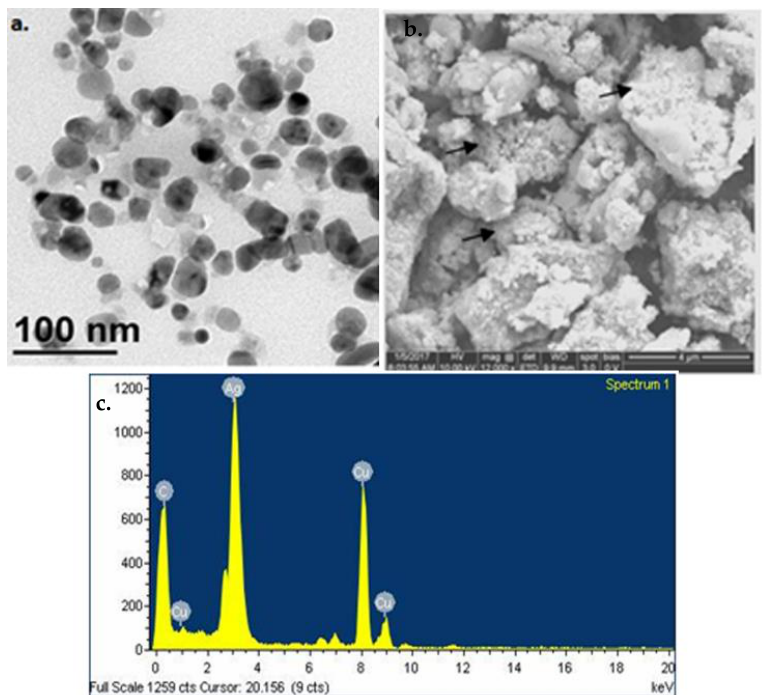
Figure 6. ( a ) TEM microscopic images of thePTAgNPs. ( b ) SEM images of the PTAgNPs.( c ) EDX spectrum of the PTAgNPs.